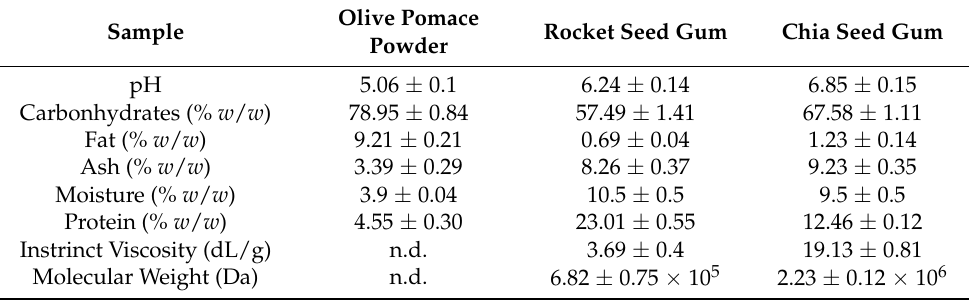
Table 1. Physicochemical properties of olive pomace, rocket seed and chia seed gum.